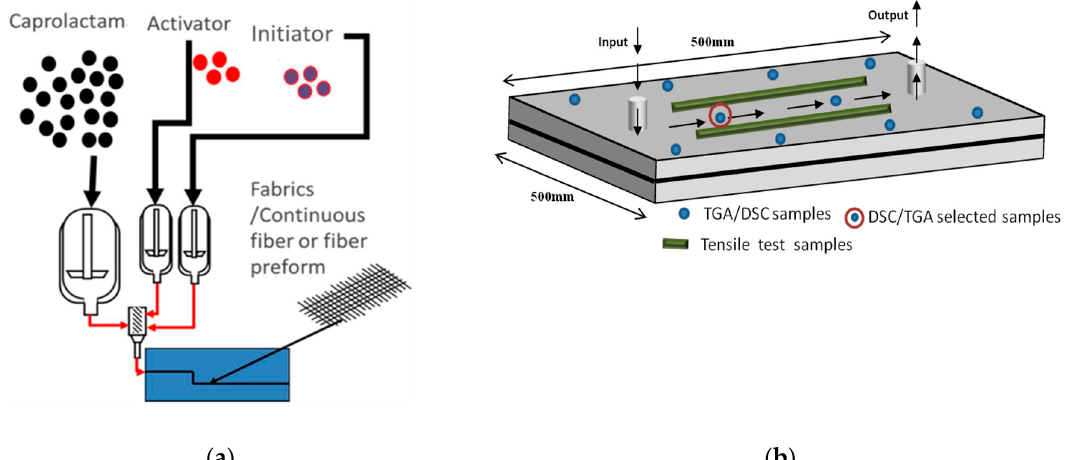
Figure 1. ( a ) Scheme of the T-RTM process employed. ( b ) Mold employed to obtain the PA6 and PA6/fibers composites plates. As indicated in the experimental part, 10 samples were tested by DSC and TGA (blue points in Figure 1b). As they were all identical, the DSC / TGA results reported in this paper are those obtained by samples collected from the central part, indicated in Figure 1b by a blue point surrounded by a red circle. The green rectangles mark the approximate position from which tensile bars were cut.